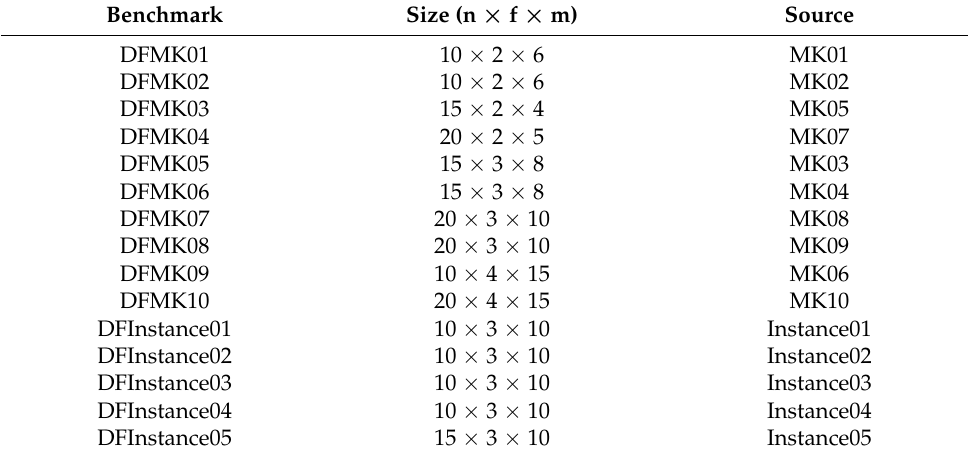
Table 2. Constructed